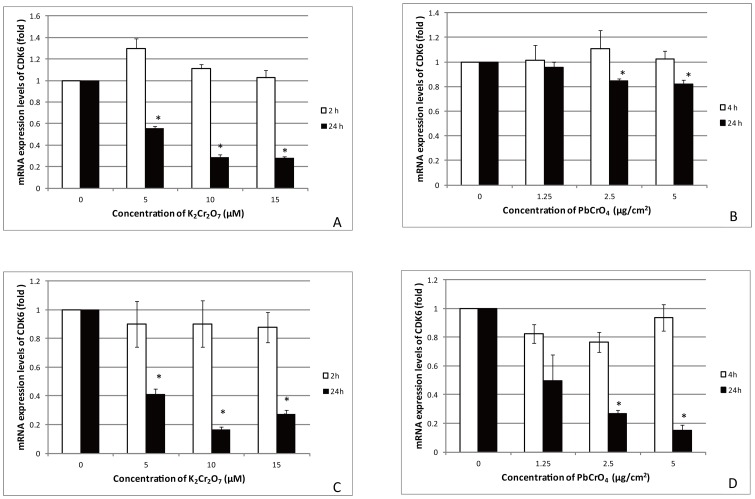
mRNA expression of CDK6 gene.A: mRNA expression levels (fold change) of CDK6 gene in human B lymphoblastoid cells (A) and in A549 cells (C) cells exposed to potassium dichromate at the concentrations of 0, 5 µM, 10 µM, and 15 µM for 2 hours and 24 hours. B and D: mRNA expression levels (fold change) of CDK6 gene in human B lymphoblastoid cells (B) and in A549 cells (D) cells exposed to lead chromate at the concentrations of 0, 1.25 µg/cm2, 2.5 µg/cm2, and 5.0 µg/cm2 for 4 hours and 24 hours. Asterisks above the bars indicate that the difference between exposure and control was significant (P<0.01).